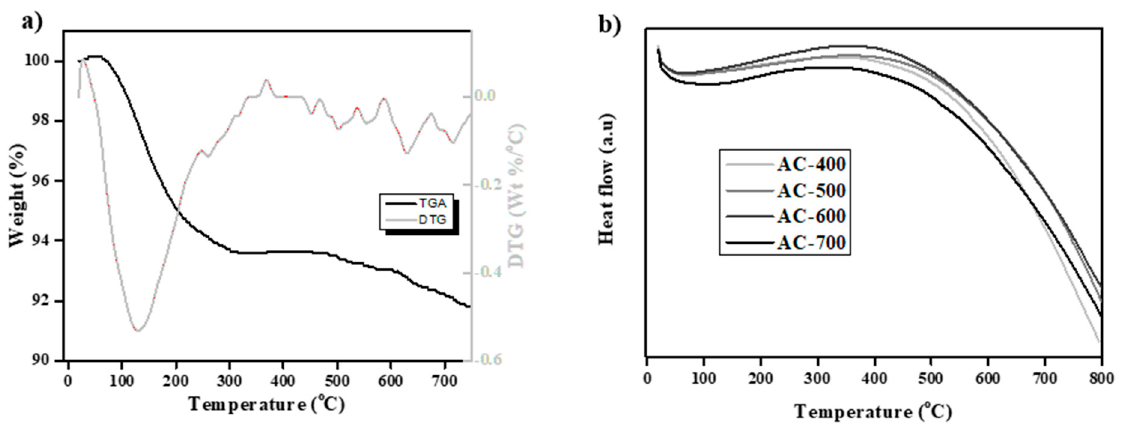
Figure 5. ( a ) TGA (black curve) and DTG (gray curve) analyses obtained for AC-700 whilst heating to 800 °C (10 °C/min); ( b ) DSC curves of AC-400, AC-500, AC-600, and AC-700 samples.